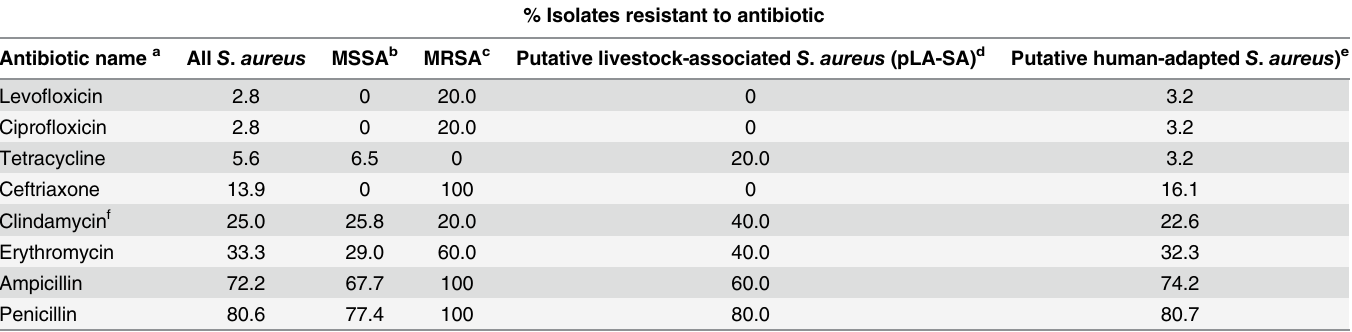
Table 4. Prevalence of antibiotic resistance (% resistant) among S . aureus isolates recovered from nasal swabs of US beefpacking workers (n = 37 S . aureus